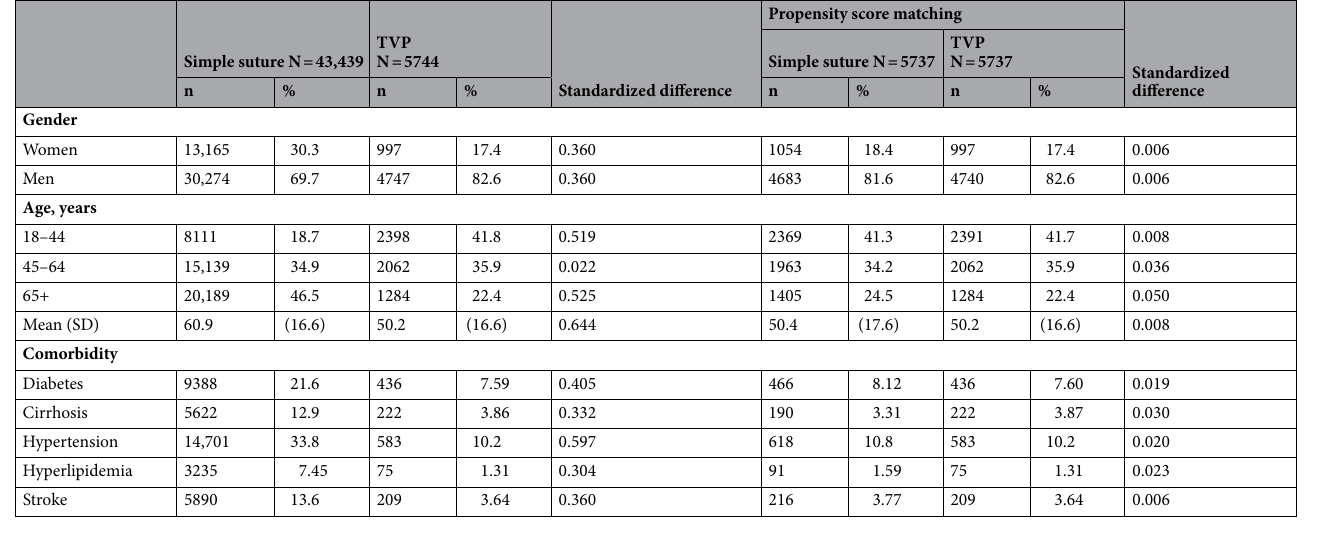
Table 1. Demographics in non-HP infected PPU patients with simple suture and TVP. SD standard deviation, HP helicobacter pylori, PPU perforated peptic ulcer, TVP truncal vagotomy and pyloroplasty.